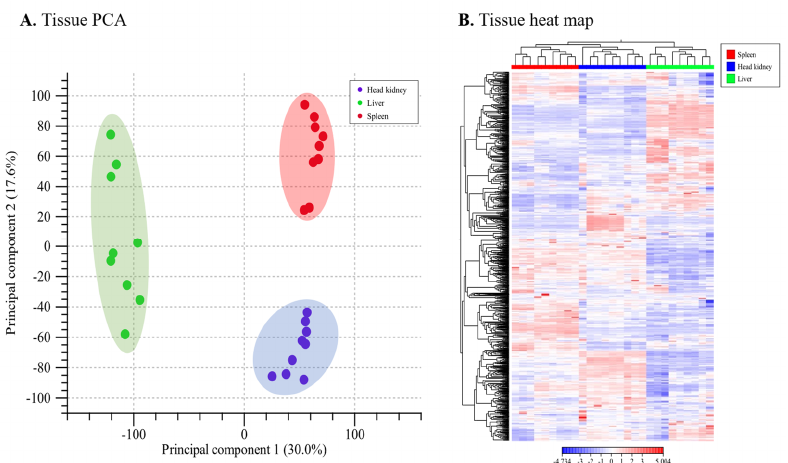
Figure 2. Clusterization of gene expression profile in different lumpfish organs infected with A. salmonicida . ( A ). Principal component analysis (PCA) of lumpfish head-kidney, spleen, and liver infected with A. salmonicida ; blue dot represents nine head-kidney tissue samples, red dot represents nine spleen tissue samples, green dot represents nine liver tissue samples; ( B ). Heat map of differential expressed genes of lumpfish head-kidney (blue), spleen (red), and liver (green) infected with A. salmonicida. The log 2 fold-change (FC) ≥ 1 and false discovery rate (FDR) p -value of ≤0.05 were set